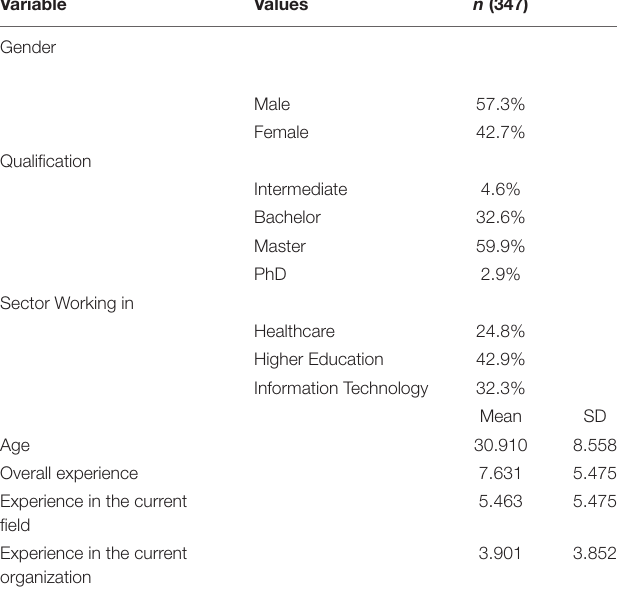
TABLE 1 | Respondents’